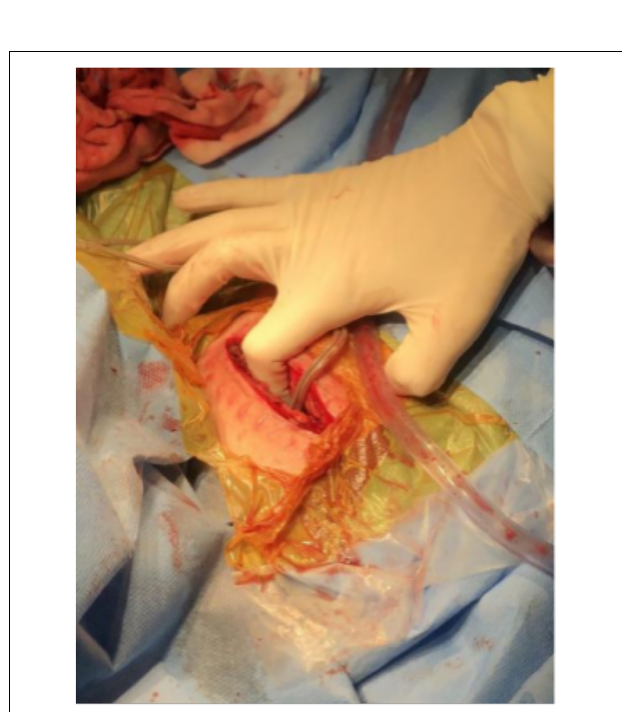
FIGURE 4 | Intraoperative figure showing the thickness of the subcutaneous fat layer which is equal to the length of the index finger to the proximal interphalangeal joint.